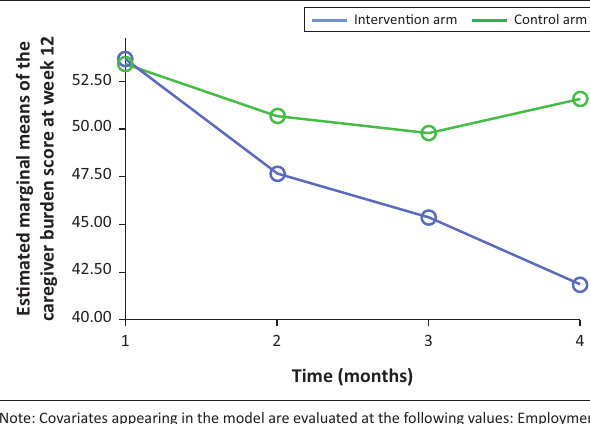
FIGURE 2: The effect of structured psychoeducation intervention and standard care on the caregiver participants’ burden of caregiving after controlling for potential